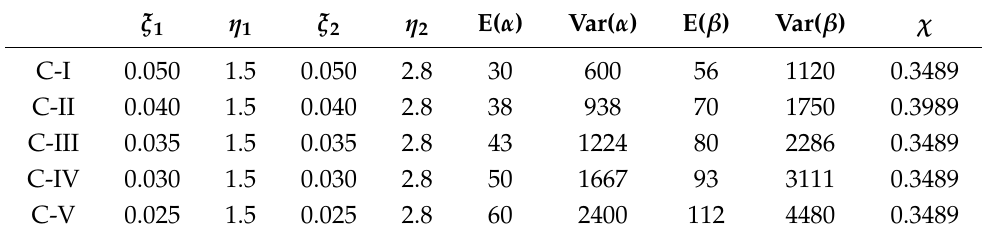
Table 1. The parameters in the hyper-prior for simulations.